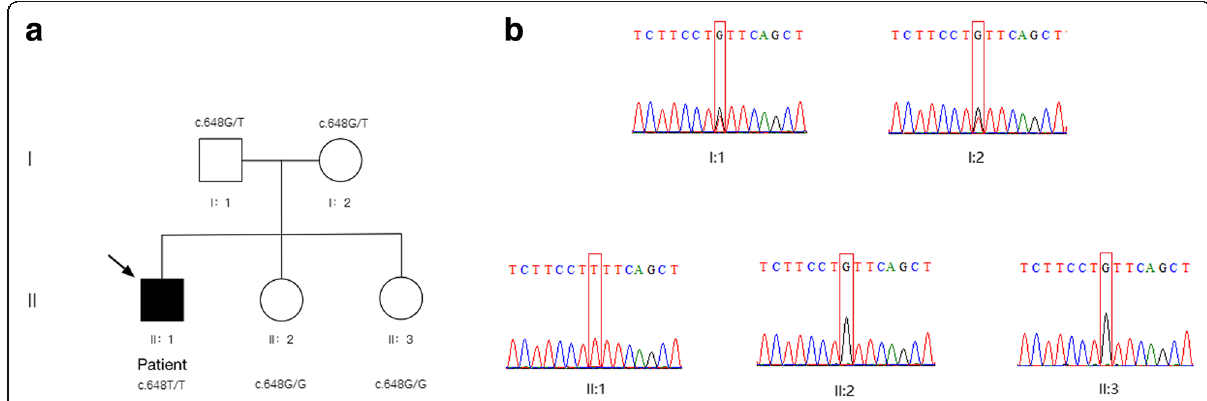
Fig. 3 Mutational analysis in the patient pedigree. a The genotypes of G6PC gene for family members. Roman numerals indicate generations and Arabic numbers indicate individuals. Squares = males, circles = females. Affected individuals are denoted by solid symbols and unaffected individuals are denoted by open symbols. The index patient is indicated by an arrow. The two mutations were inherited from father and mother respectively. b Validation for the c.G648T of exon 5 by Sanger Sequencing. The red frame was mutation